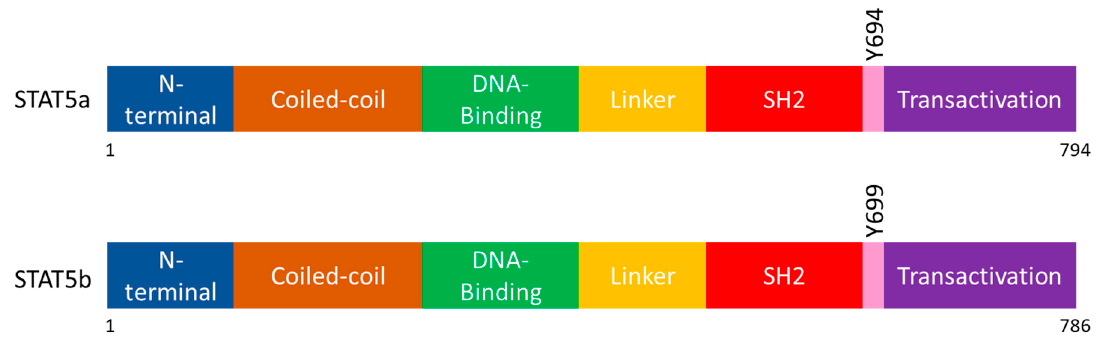
Figure 1. Structure of the STAT5 isoforms, STAT5a and STAT5b.